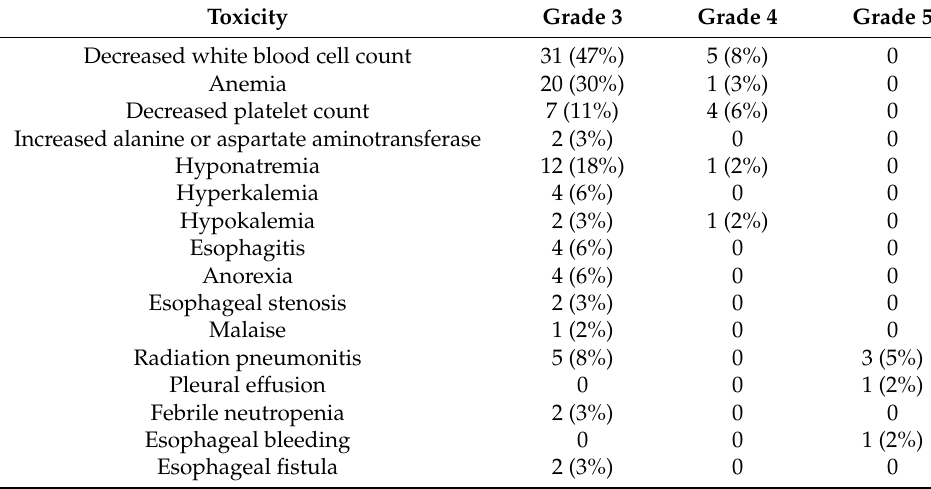
Table 6. Toxicities related to chemoradiation therapy ( n =